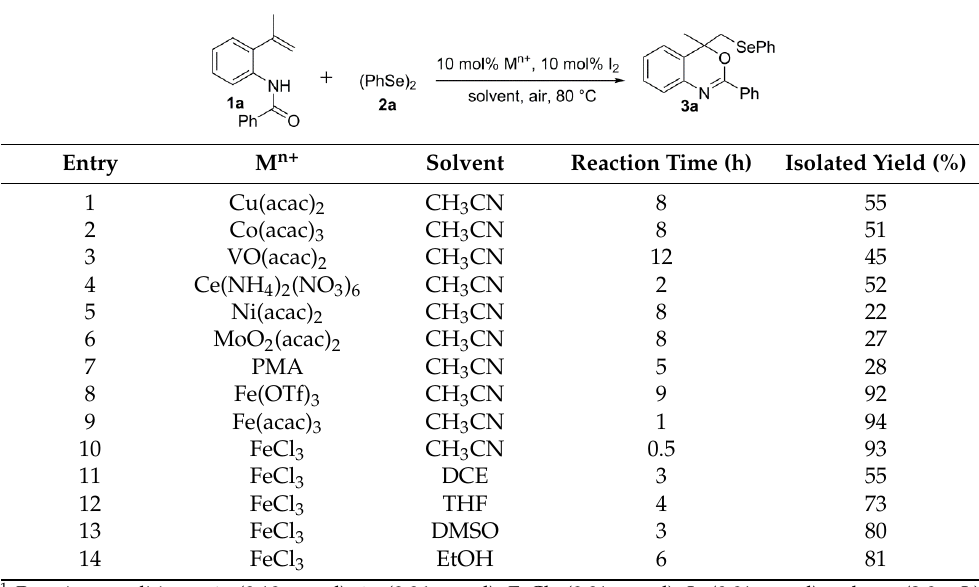
Table 1. Optimization of reaction conditions 1 .